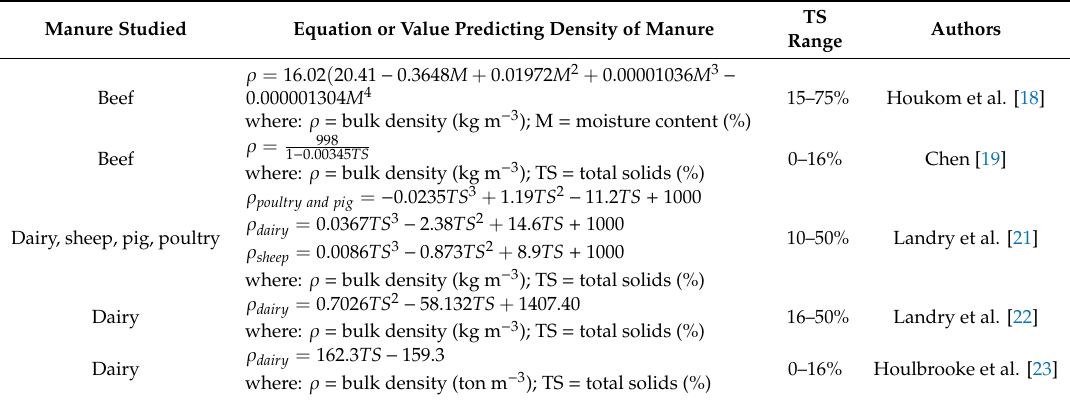
Table 1. Summary of studies that related total solids (TS) content and density of animal